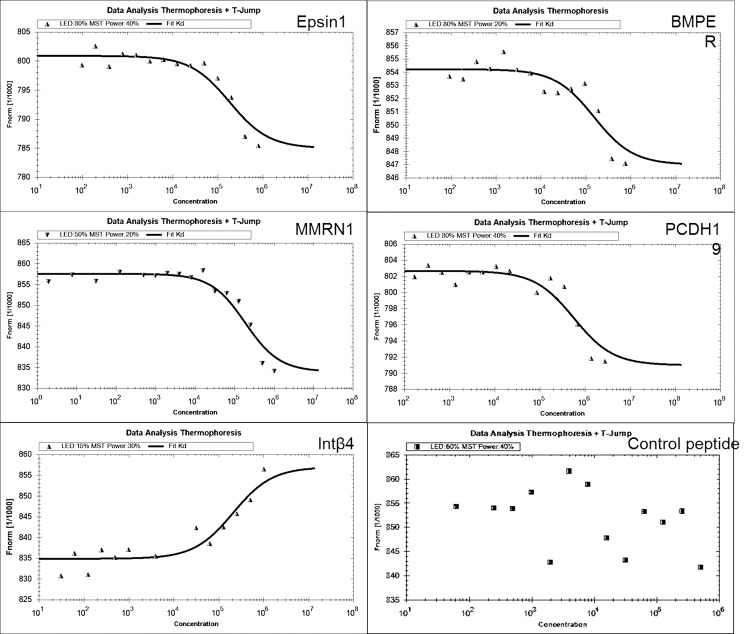
MicroScale thermophoresis (MST) analysis.In all cases, 16 serial dilutions of each putative receptor-derived peptide (~90 nM–3.175 mM) were mixed with a constant concentration of 335 nM labeled rPtsA protein. The normalized change in the fluorescence of the labeled rPtsA protein was plotted against the peptide concentration, and a fit was computed by the NTP program. The experiments were performed in triplicate. Presented here are the affinities of rPtsA binding to: the Eps1-derived peptide Kd = 43.900 ± 9.35 μM; the BMPER-derived peptide Kd = 21.00± 5.49μM; the MMRN1-derived peptide Kd = 391 ± 72.7 μM; the PCDH19-derived peptide Kd = 58.00 ± 13.4 μM; and the Int β4-derived peptide Kd = 115±20.5μM. For the control, namely, the Nox putative receptor (contactin 4)-derived peptide, a fit could not be generated due to a very low signal-to-noise ratio.